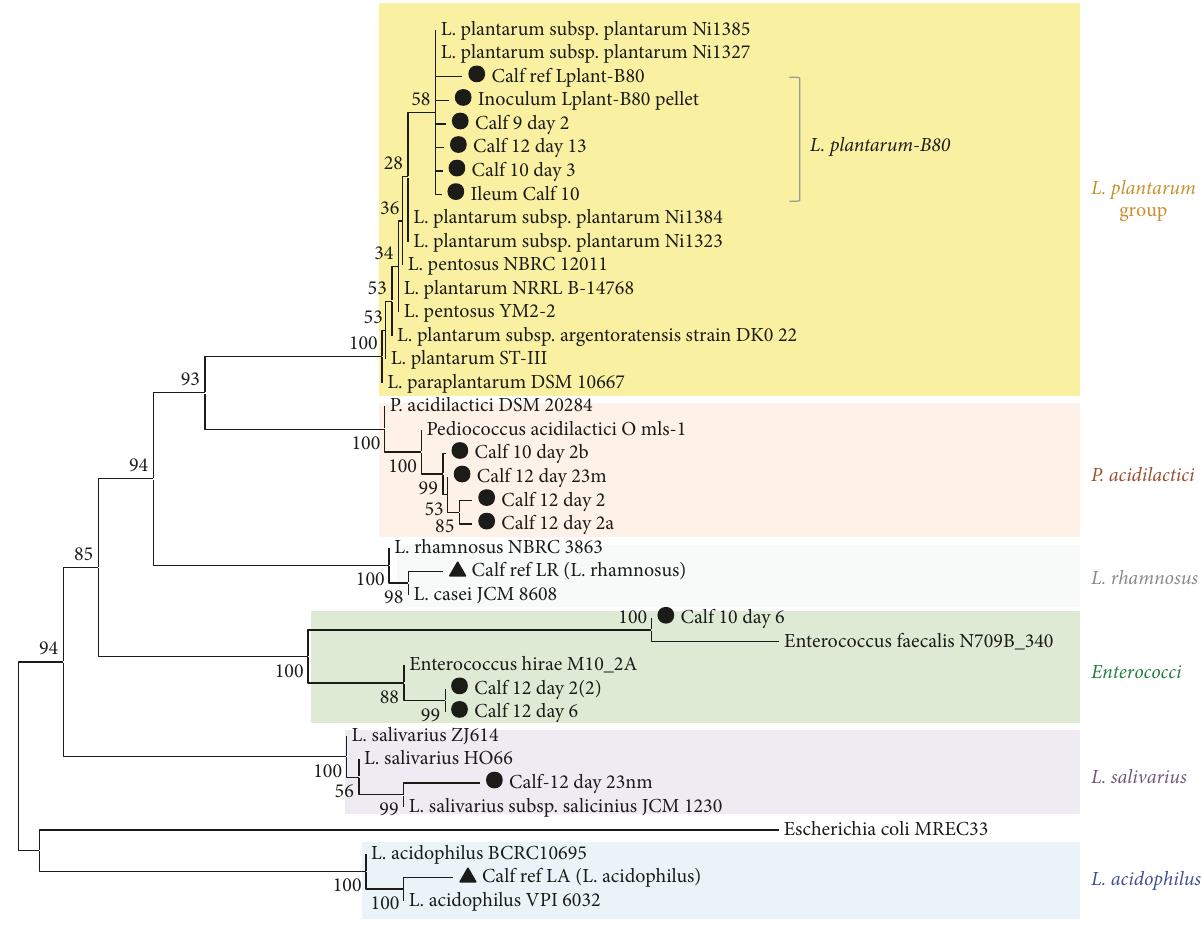
Figure 4: Neighbour-joining of 16S rRNA gene sequences of LAB from calves in this study. Numbers indicate percentage of replicate trees in which the associated taxa clustered together in the bootstrap test. Branch lengths are evolutionary distances, that is, units of the number of base differences per site. A total of 1614 positions were the final dataset. LAB isolates from this study ( e ) and internal laboratory references ( 󳵳 ). Remarkably the closest isolates in the NCBI collection are a group of isolates isolated from grass silage in